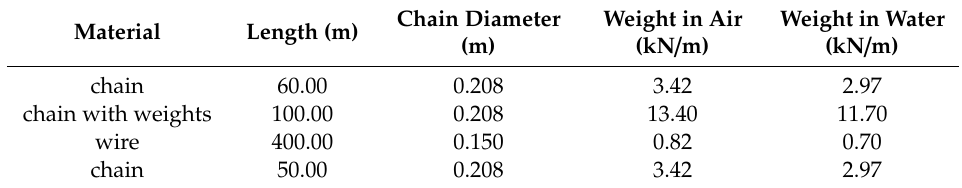
Table 4. Mooring system properties in the full scale.